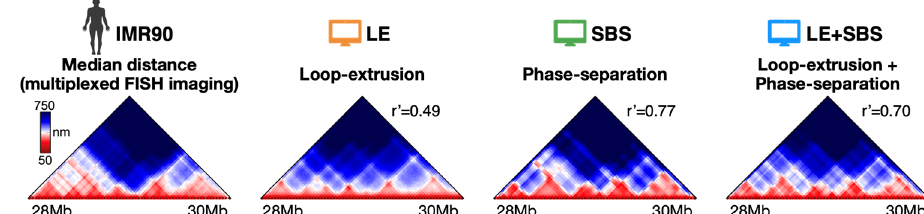
Figure 1. The median spatial distance matrix of the IMR90 locus (Chr21: 28–30 Mb) from multiplexed FISH microscopy [15] is compared against the corresponding in silico matrices of the considered polymer models [28]. Both loop-extrusion (LE) and phase-separation based models (SBS and LE + SBS) well recapitulate the complex experimental pattern of contacts. Adapted from [28].